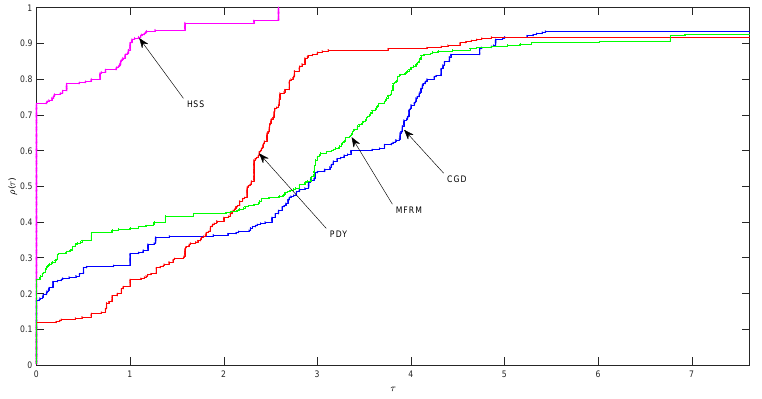
Figure 1. Dolan and Mor´ e performance profile with respect to number of iterations.